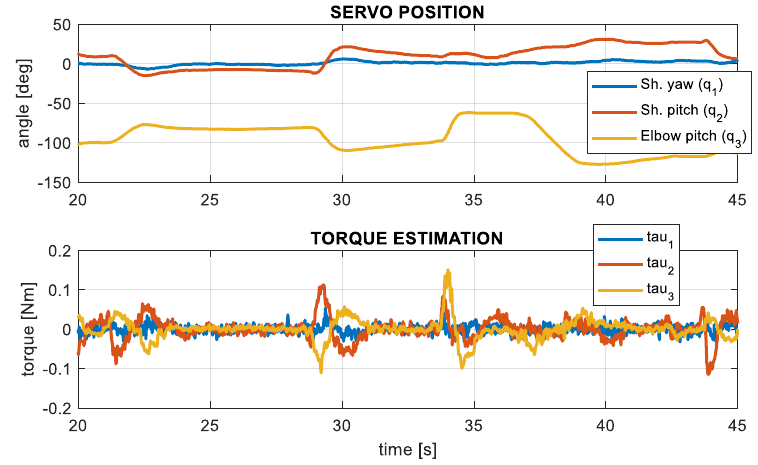
Figure 10 . Evolution of the servo position and torque estimation during the grabbing maneuver. Figure 10. Evolution of the servo position and torque estimation during the grabbing